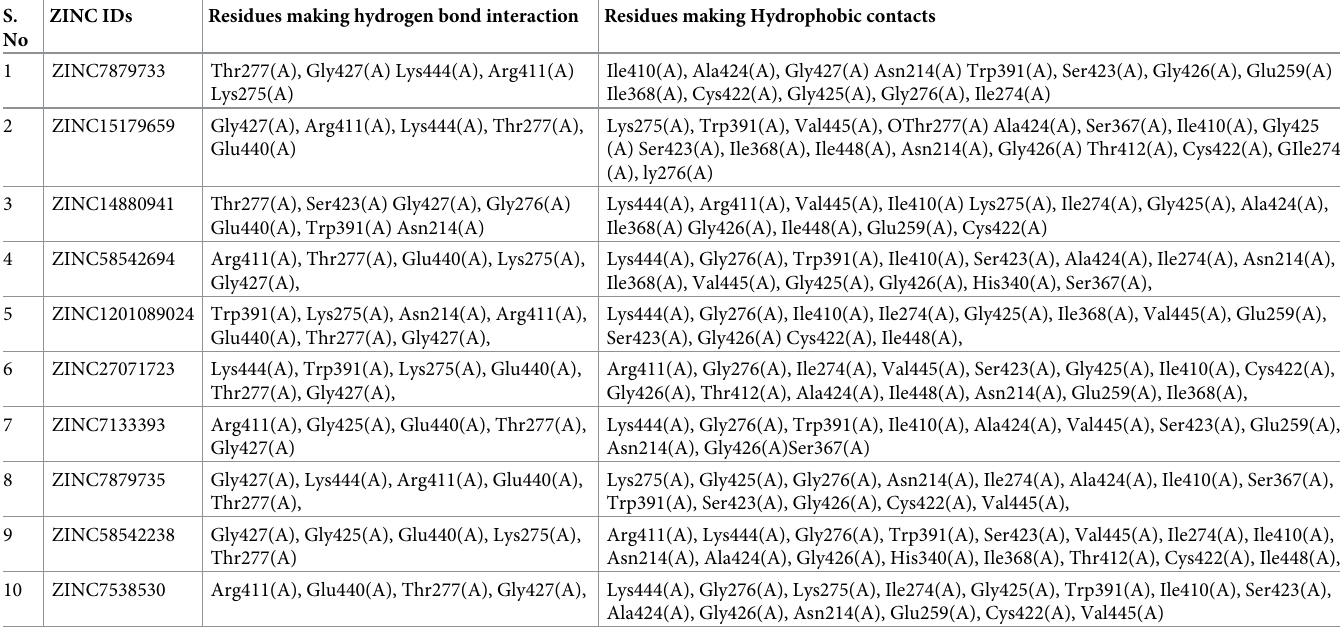
Table 4. Protein residues involved in the hydrogen and hydrophobic interactions with top ten best ranking compounds (ligands), analyzed through